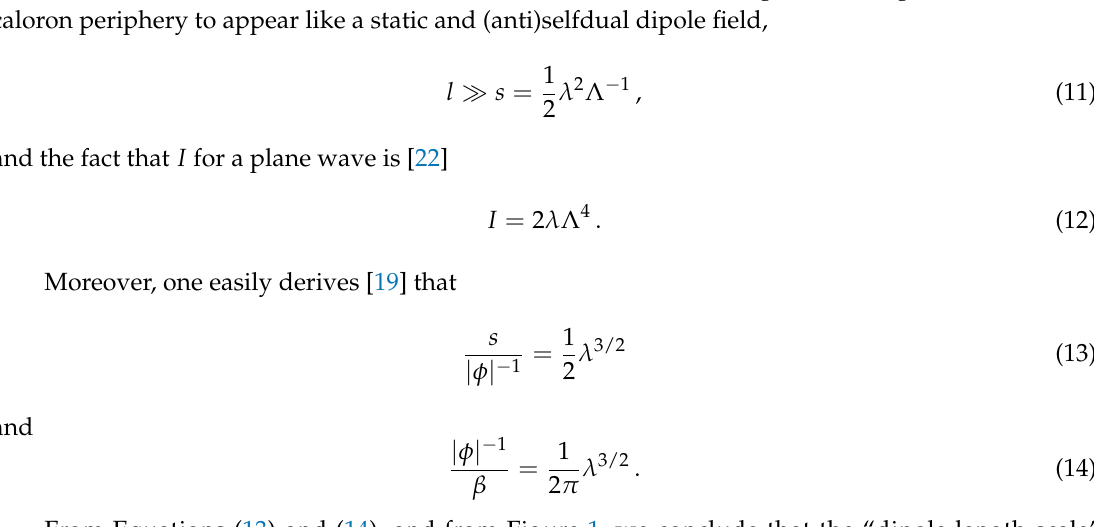
Figure 1. Plot of the ratios s